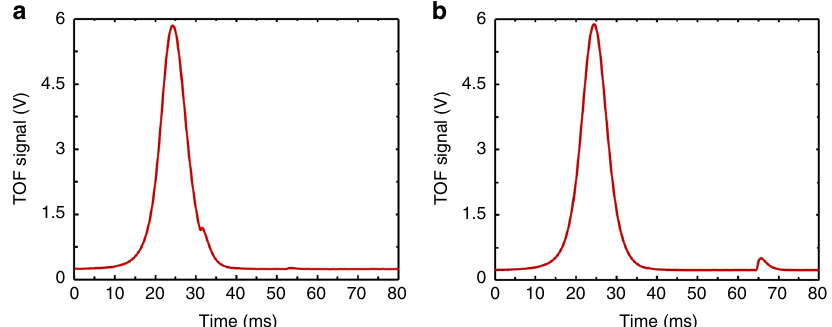
Fig. 7 Interfered TOF signals in the SAA region. Interference spikes located a on the TOF signal and b near the TOF signal when the spacecraft moves in the SAA region. Time t = 0 is the start time of the detection process